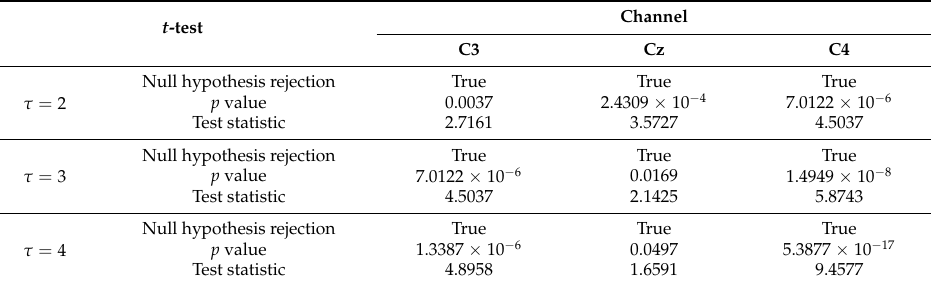
Table 5. Paired t -test